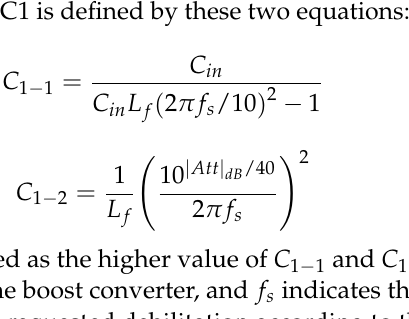
Figure 16. EMI filter design for the proposed boost converter.